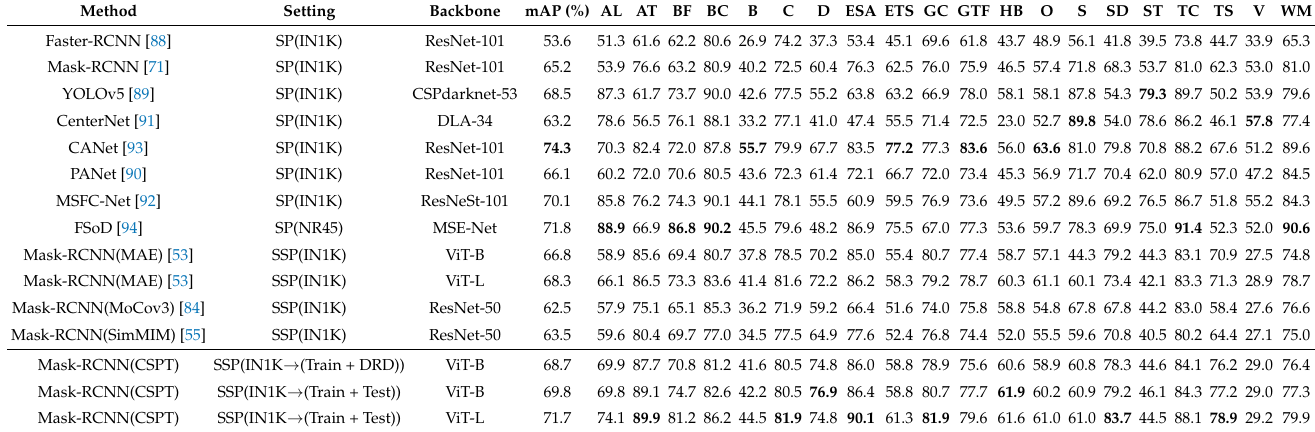
Table 6. The comparison results on DIOR [23]. The best results are marked in bold.